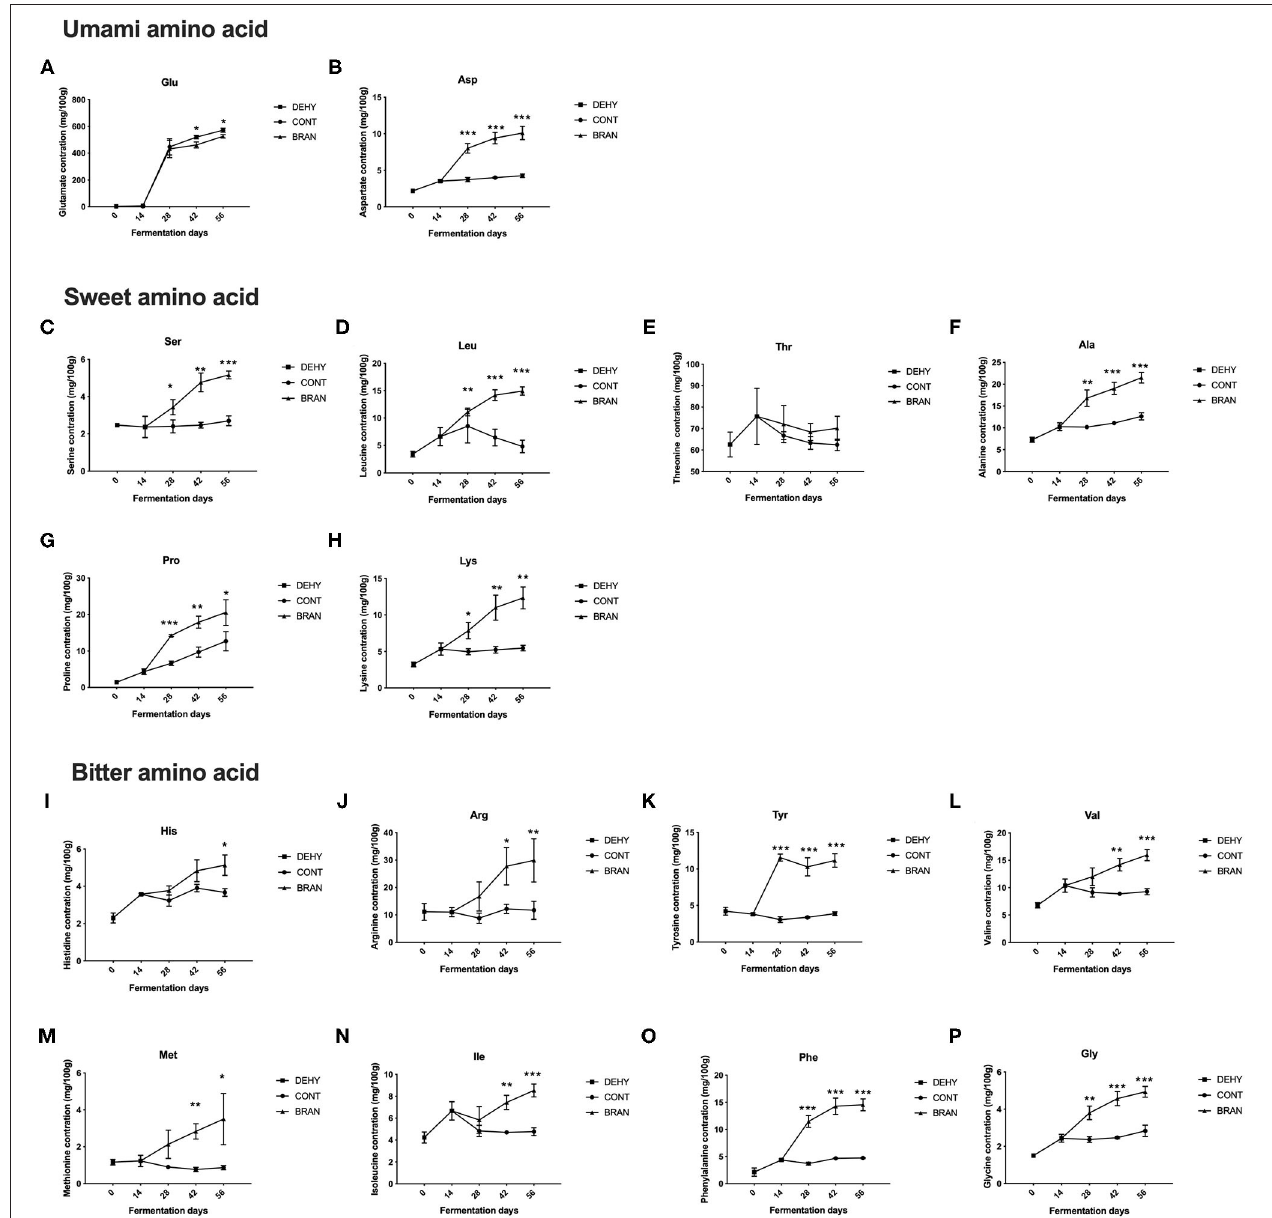
FIGURE 1 | Changes in FFA concentrations during the pickling process of radish roots, showing umami amino acid (A, B) , sweet amino acid (C–H) , and bitter amino acid (I–P) , where DEHY: dehydration stage, including days 0 (the start of dehydration) and 14, CONT: seasoning stage (days 28, 42, and 56) of the fermented radish without wheat bran, and BRAN: seasoning stage (days 28, 42, and 56) of the fermented radish with wheat bran. The data are presented as mean ± SD ( n = 3), and significant differences within each seasoning period between CONT and BRAN are marked as * p < 0.05, *** p < 0.001. 28th day and then decreased during the deterioration stage in the CONT group (day 56). Thus, the addition of wheat bran resulted in a decrease in glucose (day 28: 0.8 vs 2.1g/100 g, P = 0.012; D42: 1.1 vs 0.32 g/100 g, P = 0.001) and fructose (D42: 0.5 vs 2.4 g/100 g, P < 0.001) concentrations in the pickled radishes during the maturation